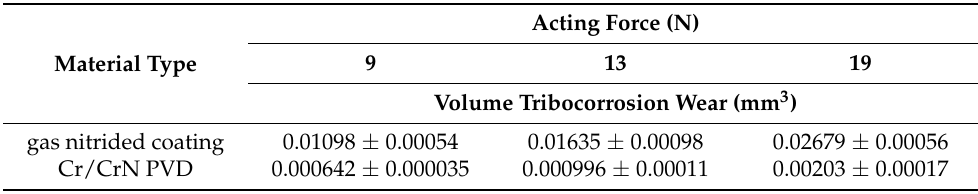
Table 5. Tribocorrosion wear of investigated materials related to different acting forces on the basis of the volume wear.